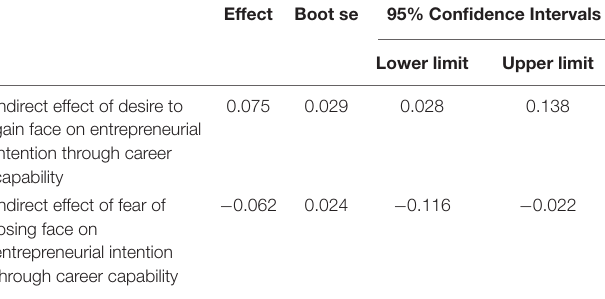
TABLE 4 | The bootstrap result on mediating effect by the PROCESS procedure (Model